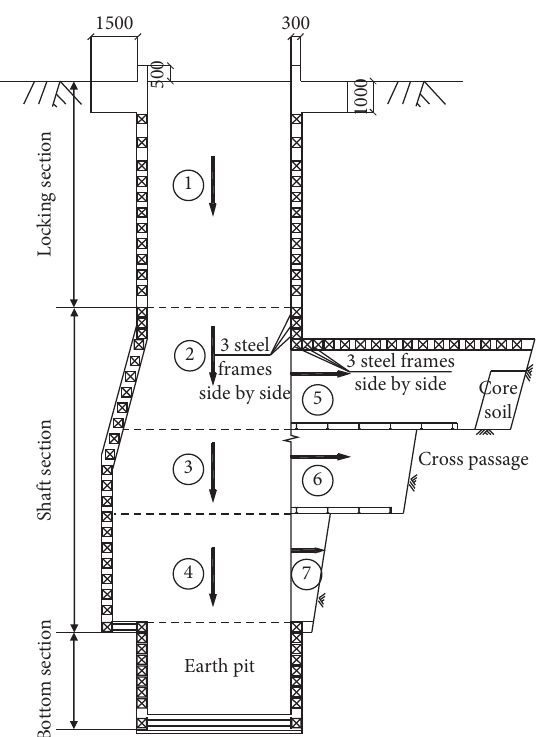
Figure 3: Construction sequence diagram of ingate with shaft and cross passage (unit: mm).